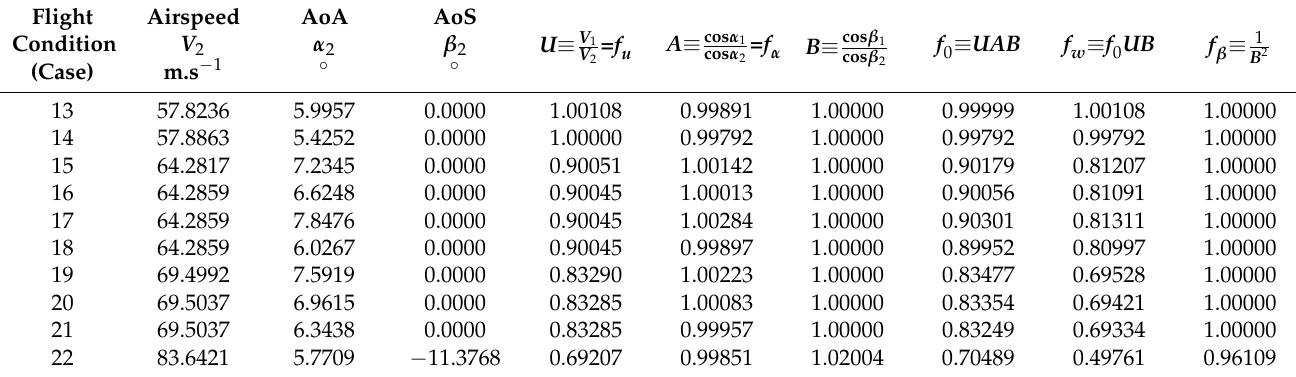
Table 6. Extrapolation from one to ten takeoff flight